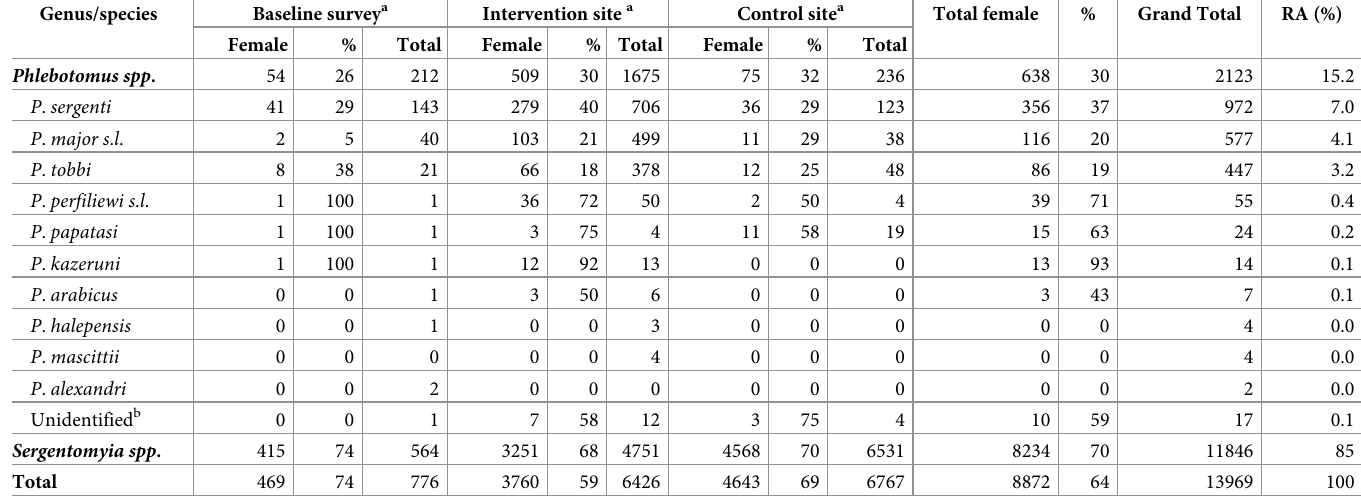
Table 1. Sand fly species composition and relative abundance (RA) during the baseline survey and in the intervention (Intervention site) and control (Control site) sites during the main study period by sex, Tayasir, Palestine, June—September 2019 (N =